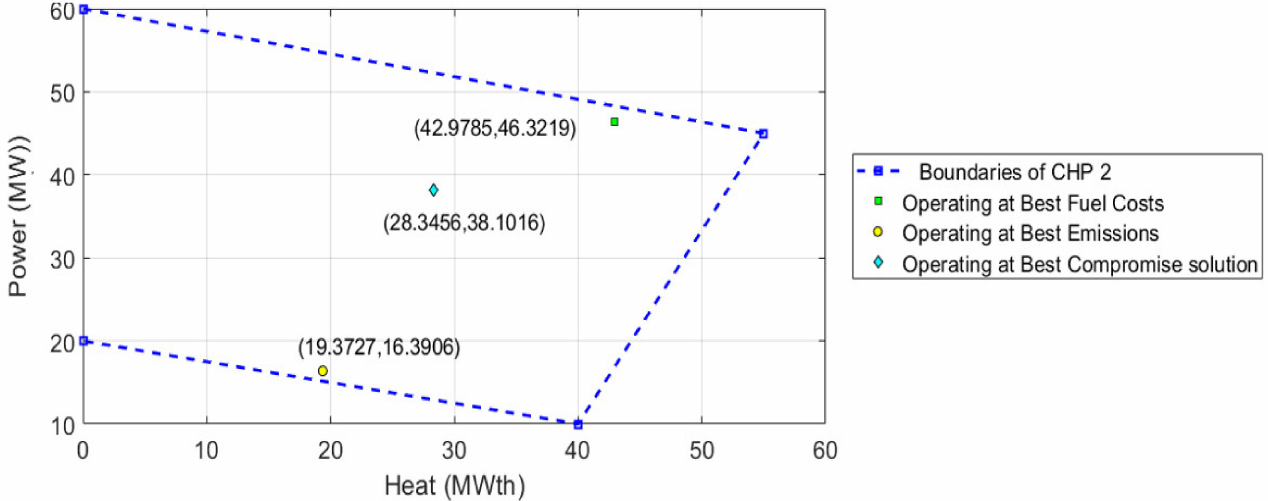
Figure 8. CHP 2 operating point versus its